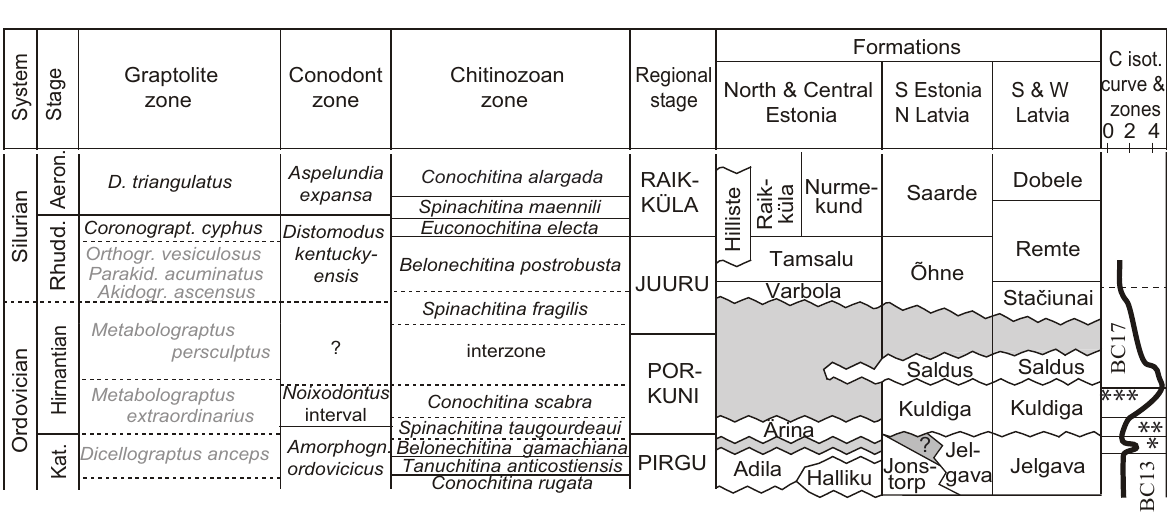
Fig. 2. Correlation of the Ordovician–Silurian boundary strata in Estonia and Latvia (after Lukševics et al. 2012 and Meidla et al. 2014) and the graptolite, conodont and chitinozoan zones (compiled after Nõlvak et al. 2006, Loydell et al. 2010, Nestor 2012 and Männik 2014). The lower boundary of the Spinachitina taugourdeaui chitinozoan Zone is drawn by considering the appearance of this species in the Pirgu Regional Stage, below the HICE excursion, in the Tartu core (Bauert et al. 2014) and the Rapla core (Kaljo et al. 2004). The shaded text in the column of graptolite zonation refers to the lack of graptolite evidence in the respective zonal units within the study area. The dashed lines for the zonal boundaries refer to their uncertain position. The isotopic zones BC14, BC15 and BC16 (Ainsaar et al. 2010) are marked by one, two or three asterisks (respectively) in the right